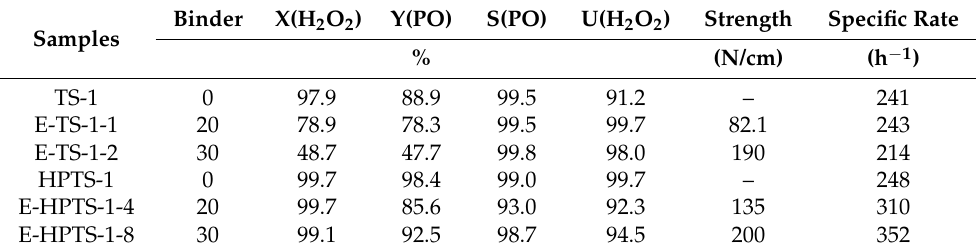
Table 2. Catalytic performance of extruded TS-1 and HPTS-1 samples in propylene